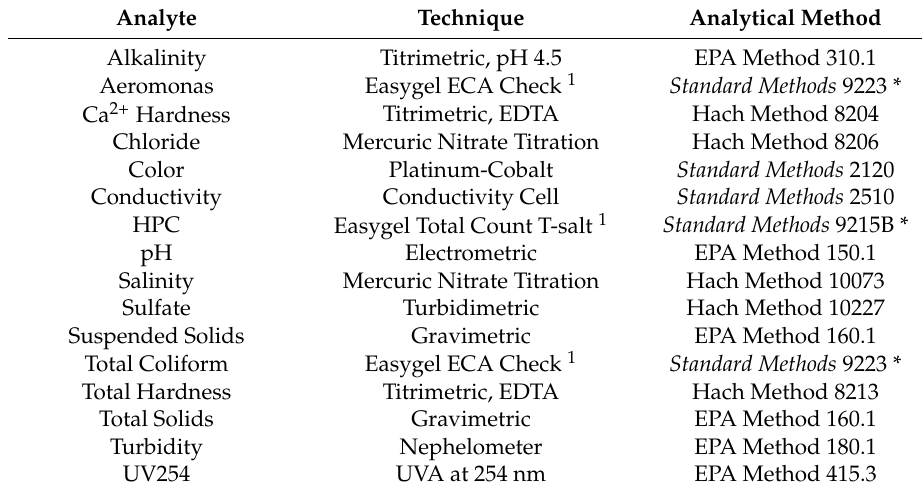
Table 3. Analytical Methods.